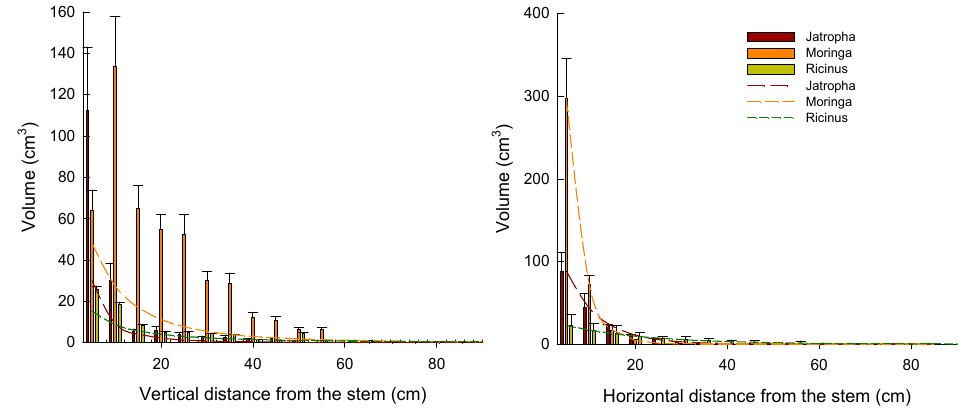
Figure 5. Root volume distribution of Jatropha , Moringa , and Ricinus 83 days after root pruning and transplanting. Vertical error bars represent the standard error of the mean. The dashed lines represent the estimated models.